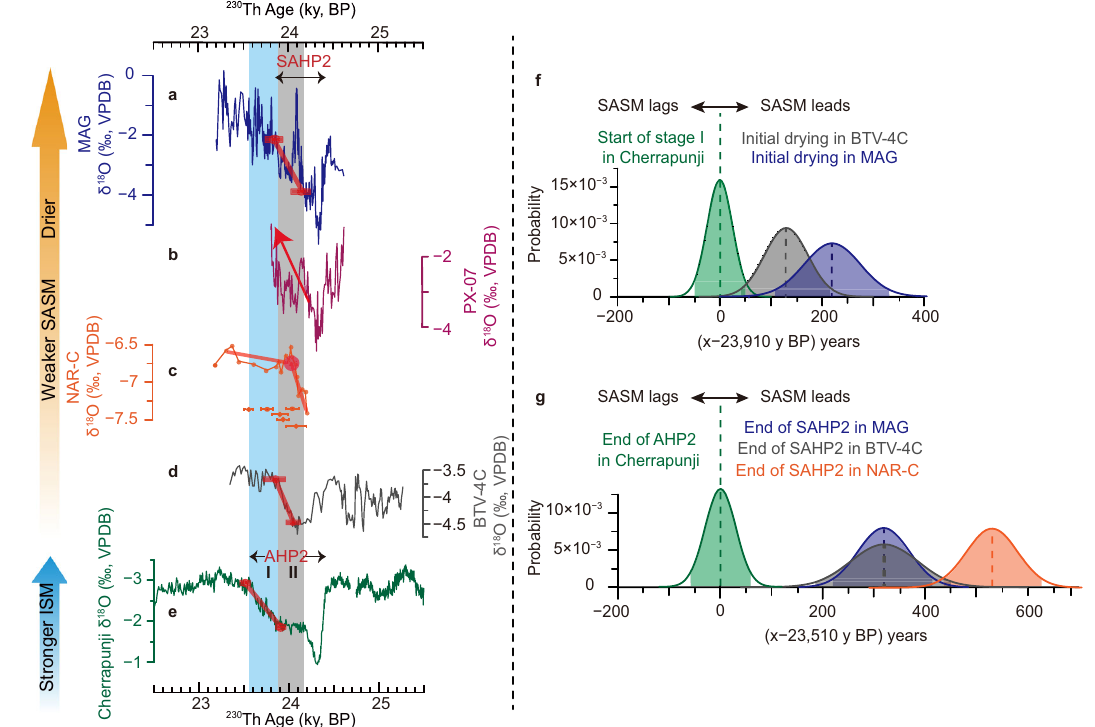
Fig.6|SpeleothemrecordsfromSouthAmericaandtheirphasingrelationship with Asian summer monsoon records during AHP2 and SAHP2 terminations. a – d SASM speleothem δ 18 O records from Marota Cave (MAG, this study), Paixão Cave (PX-07, this study), Cueva del Diamante Cave (NAR-C, this study and ref. 8), and Botuverá Cave (BTV-4C, this study). e ASM speleothem δ 18 O record from CherrapunjiCave(thisstudy)(notetheinvertedy-axis).Cavelocationsareshownin Fig.2f,g.Errorbarsin( c )depict 230 Thdatesand2 σ errorsoftheNAR-Crecord.Red dots and associated error bars in ( a ) and ( c – e ) indicate timing and combined uncertainties(2 σ )ofthechangepointsinspeleothem δ 18 Orecords(Supplementary Table 2), red lines in ( a ) and ( c – e ) show the ramps and break lines generated by